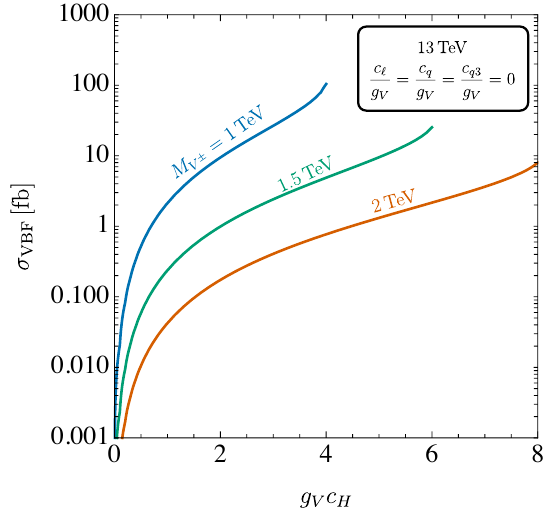
Figure 3 . The VBF production cross-section of V + + V − as a function of g V c H for resonance masses of 1, 1.5 and 2